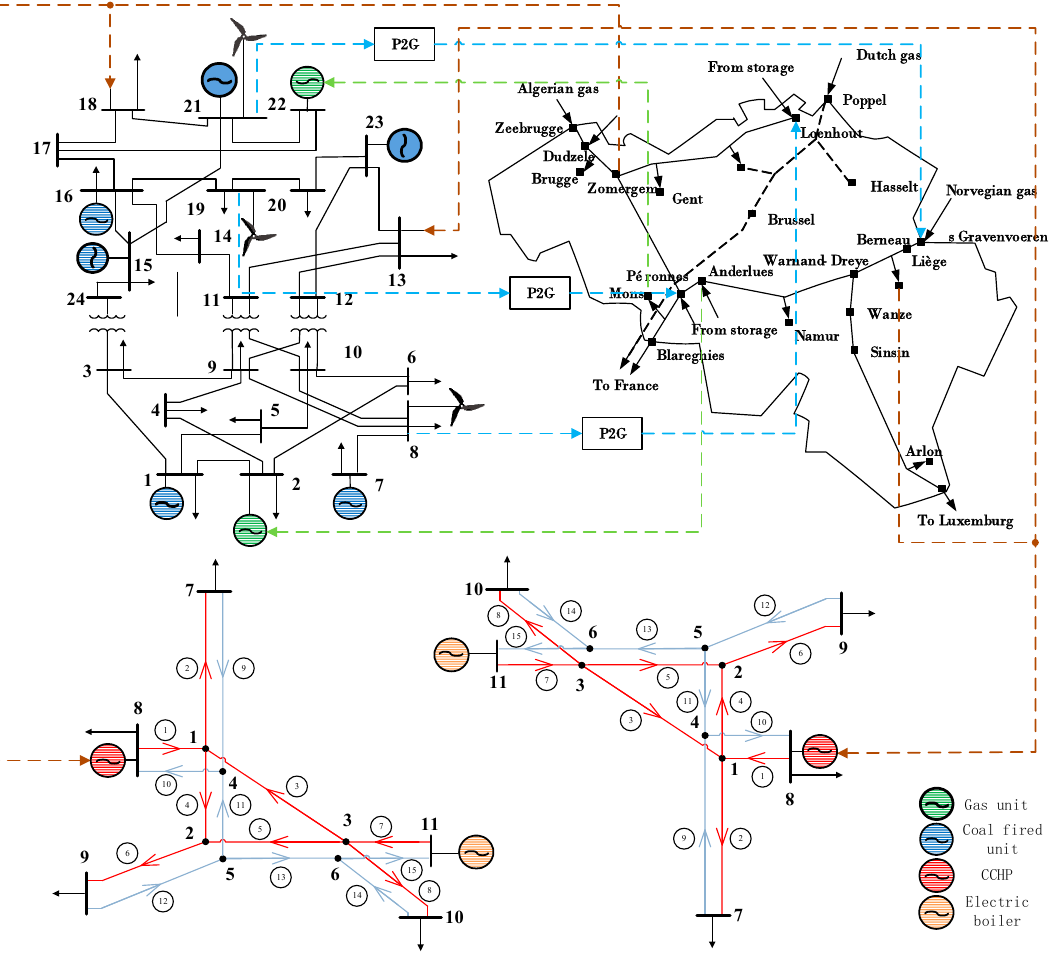
Figure 8. Integrated energy system example diagram of combined power grid, gas network and heat network.